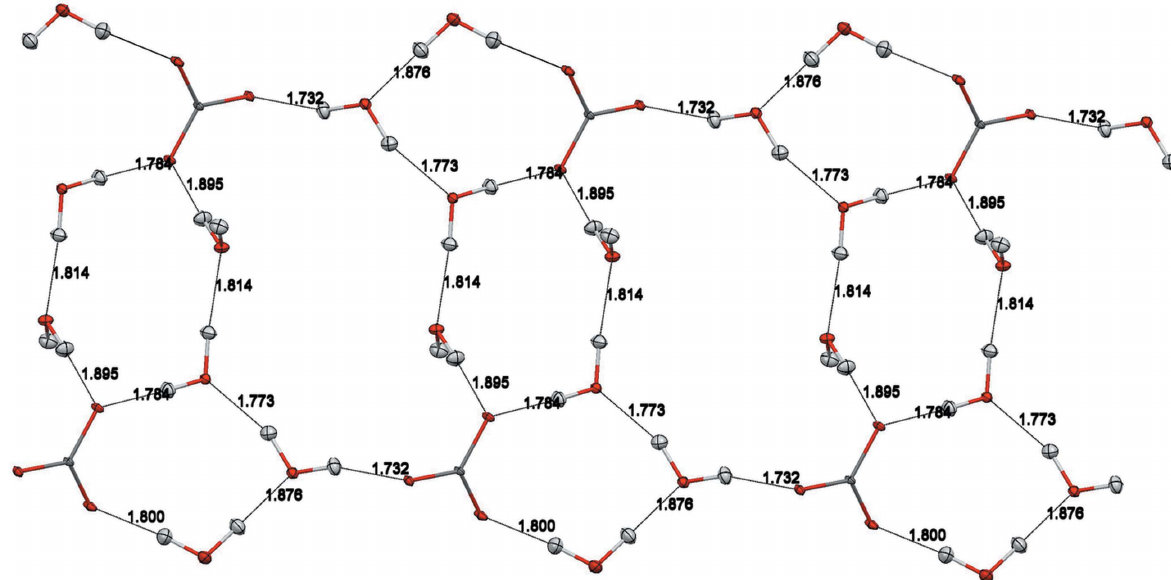
Figure 2 Potential hydrogen bonds in the anion–water ribbons. The figure is based on the neutron structure, with displacement ellipsoids at the 20% probability level and distances in A˚ (Macrae et al. , 2008). Color scheme – oxygen, red; carbon, dark gray; hydrogen, light gray.